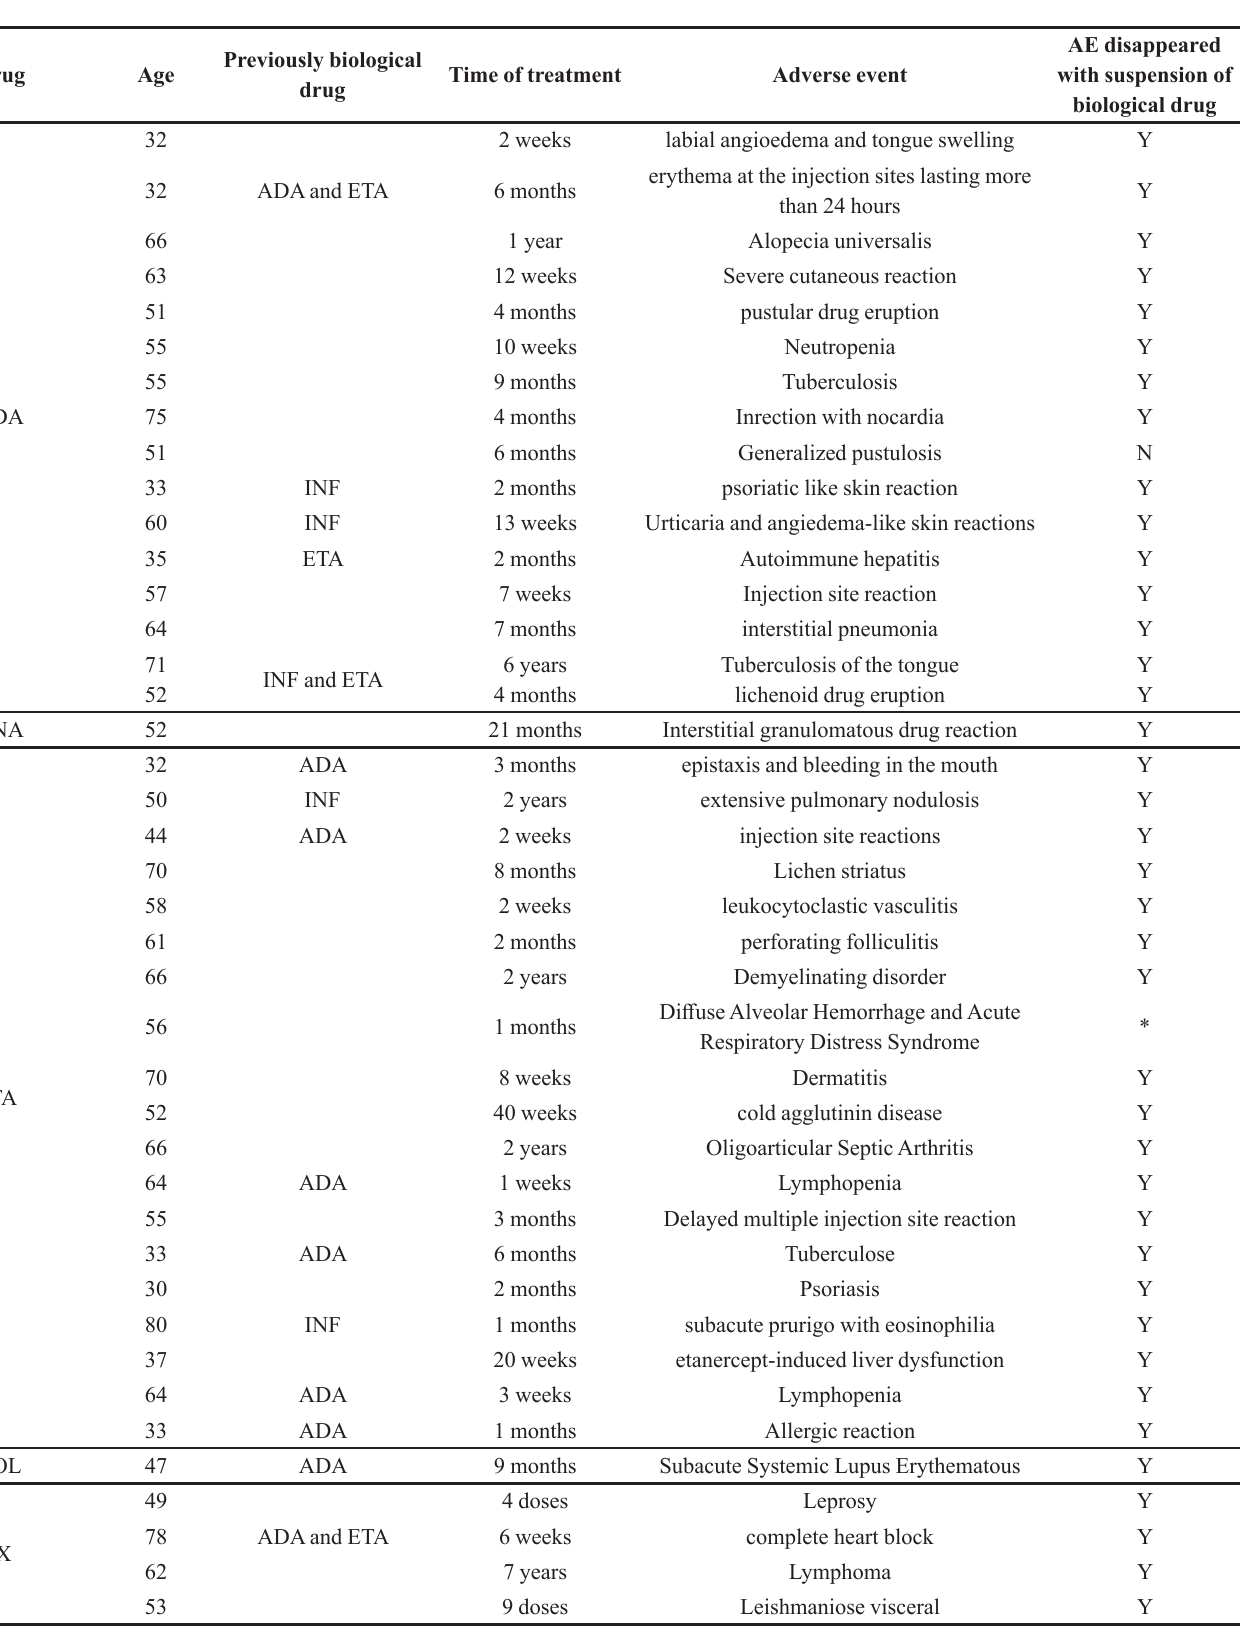
TABLE II - Description of confirmed adverse event